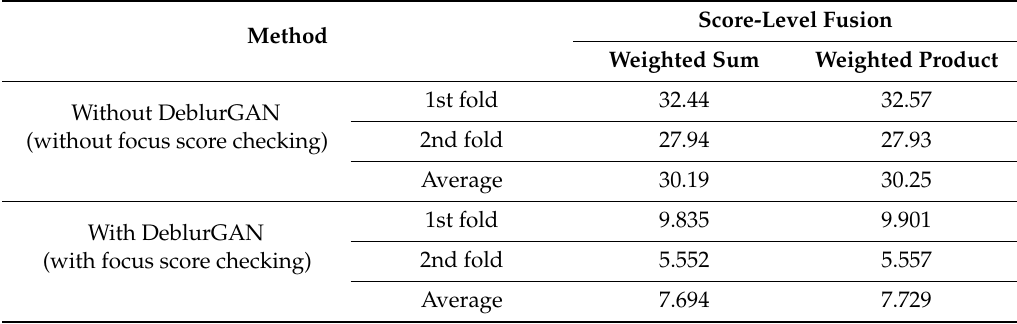
Table 6. Comparison of EER for score-level fusion on DFB-DB2 without or with DeblurGAN (unit: